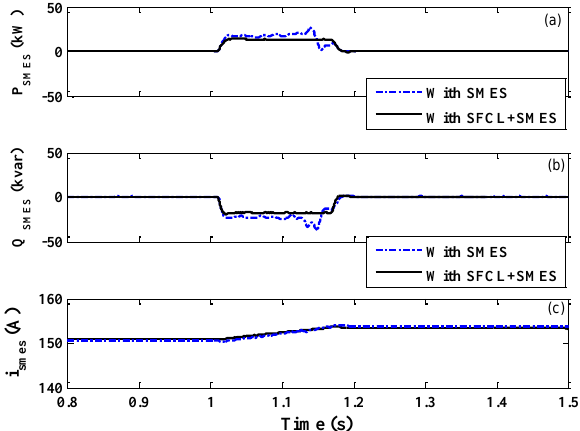
Figure 14. Characteristics of the SMES unit under the symmetrical fault. ( a ) Active power; ( b ) reactive power; and ( c ) magnet current.